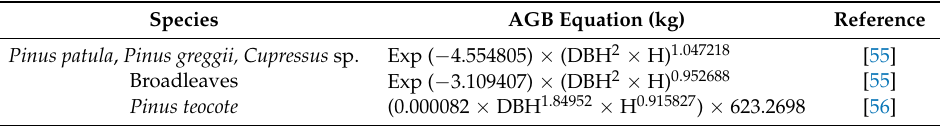
Table 1. Allometric equations used to determine tree AGB (Kg) in the forest sites. Species AGB Equation (kg) Reference Pinus patula , Pinus greggii, Cupressus